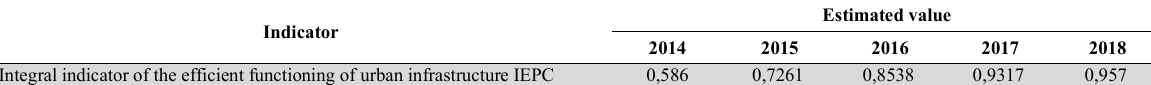
Indicators of Urban Infrastructure Performance Analysis for 2014-2018